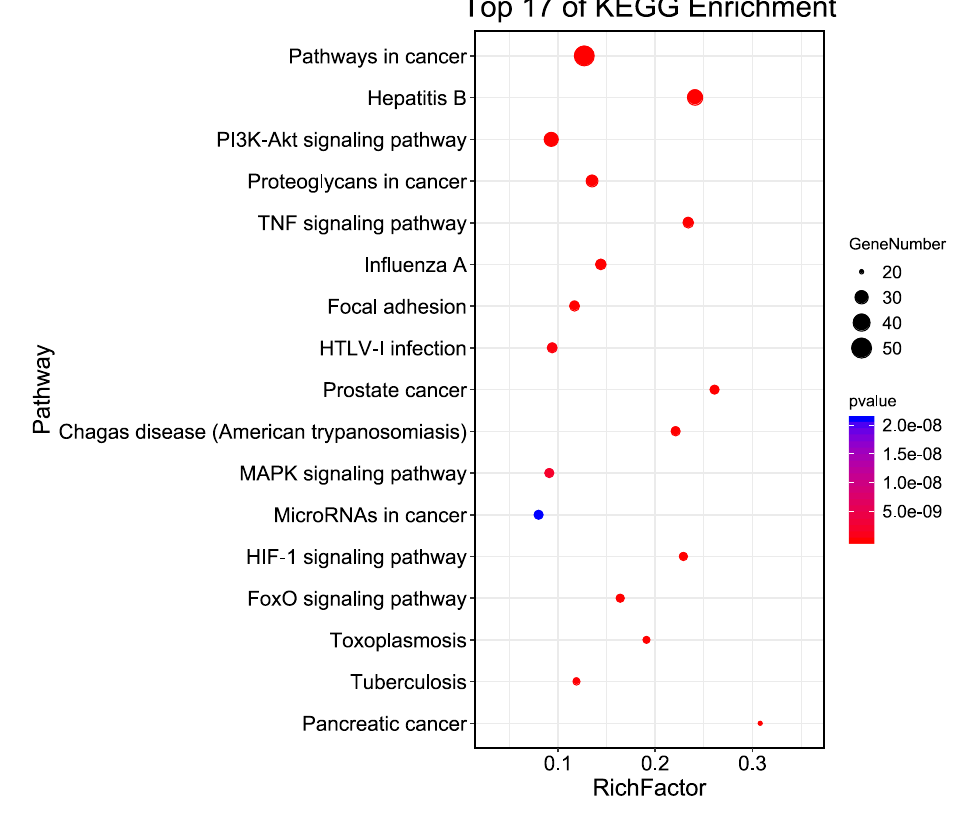
Figure 8. Pathways of AM-AS compound against DN (count >